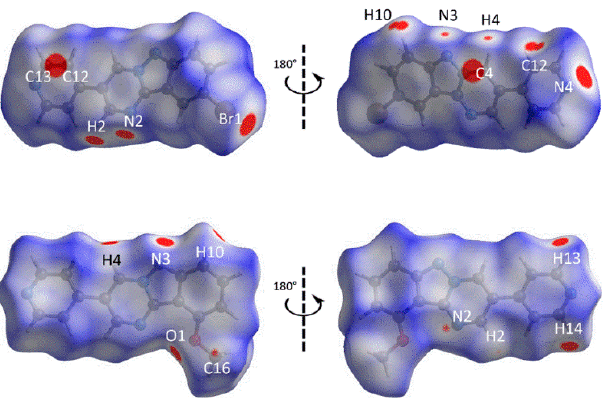
Figure 4. The two views of d norm -surfaces of 1b (top) and 1c (bottom), showing the close contacts as indicated by the red spots of variable intensity which are directly proportional to the contact distance (property range: − 0.0538 to 1.1022 arbitrary units). Table 3. List of contact distance between the corresponding red spots as identified on the d norm - surfaces for 1b and 1c .